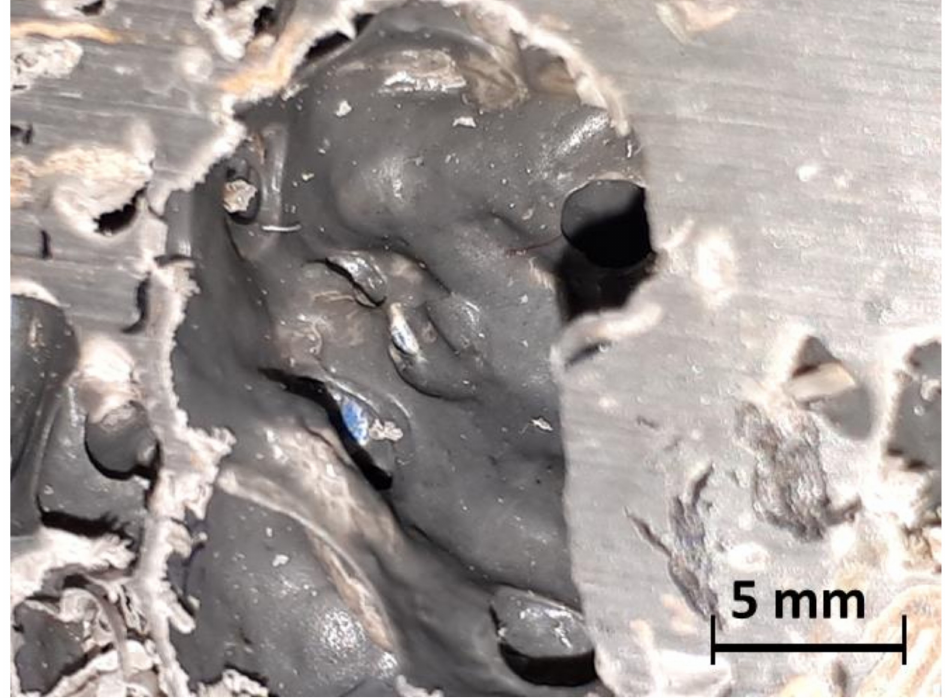
Figure 7. The interior of a porous region within the re-formative polymer (this